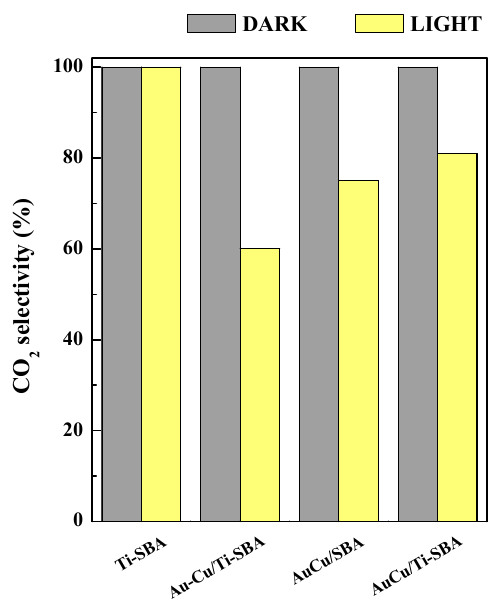
Figure 12. CO 2 selectivity for the CO preferential oxidation in excess of hydrogen in dark and light mode.